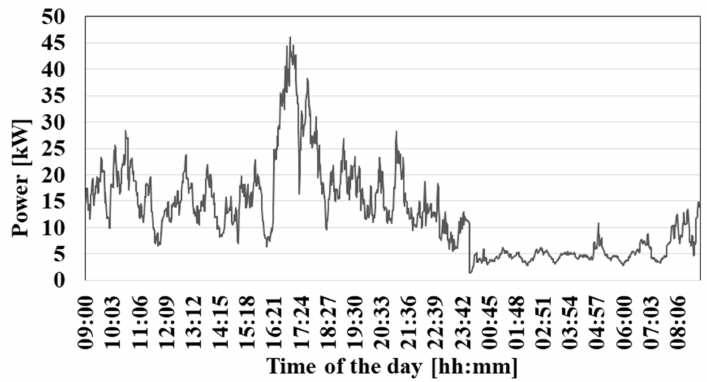
Figure 3. Total expected load–demand of residential community without power outage.